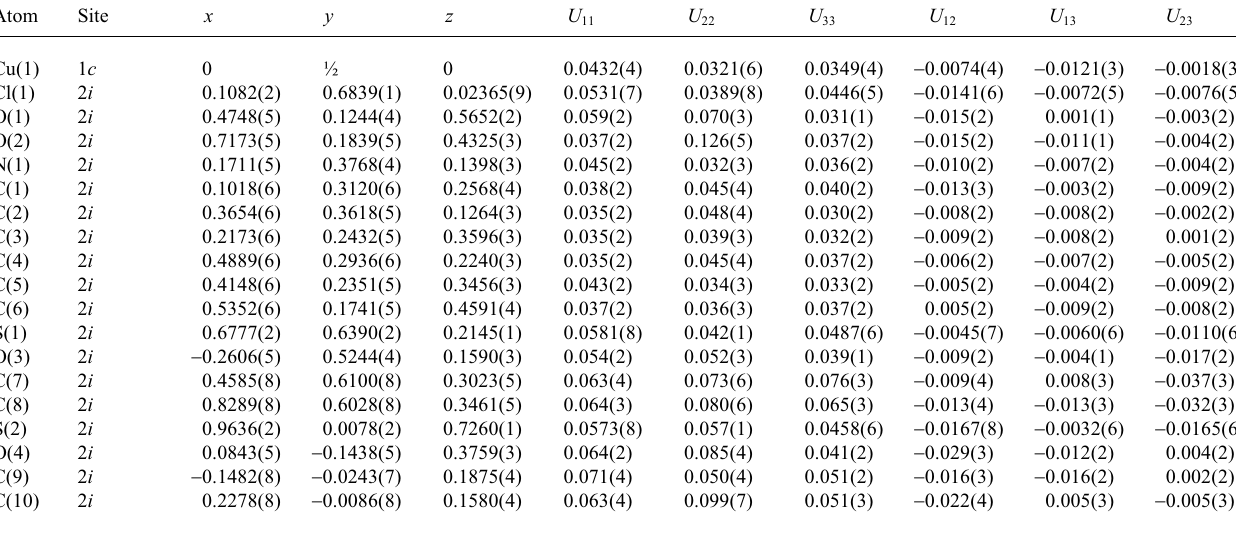
Table 3. Atomic coordinates and displacement parameters (in Å 2 ).